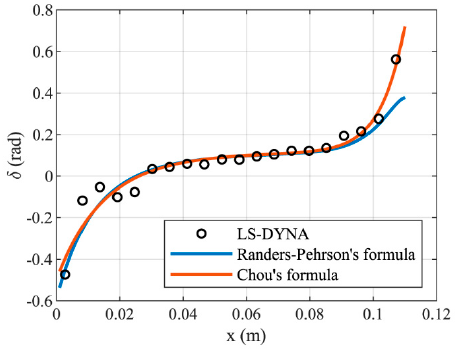
Figure 4. Projection angle fitting result.